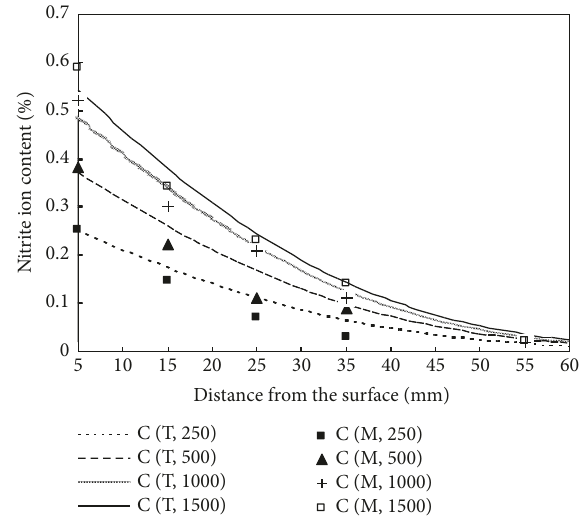
Figure 5: Nitrite ion concentration in